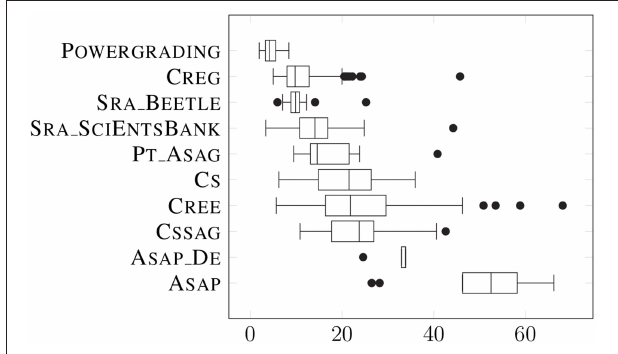
FIGURE 3 | Average lengths of answers per